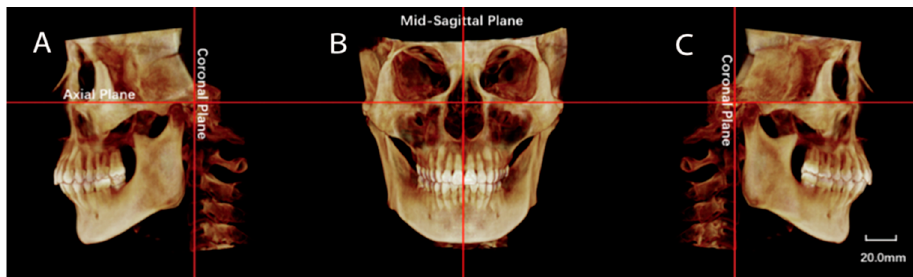
Figure 1. Orientation of the CBCT scan before measurements. ( A , C ): Alignment of the Frankfort- horizontal (FH) plane and transporionic vertical plane from the left ( A ) and right ( C ) view of 3D reconstruction. ( B ): Alignment of the FH plane and the midsagittal plane from the front view.